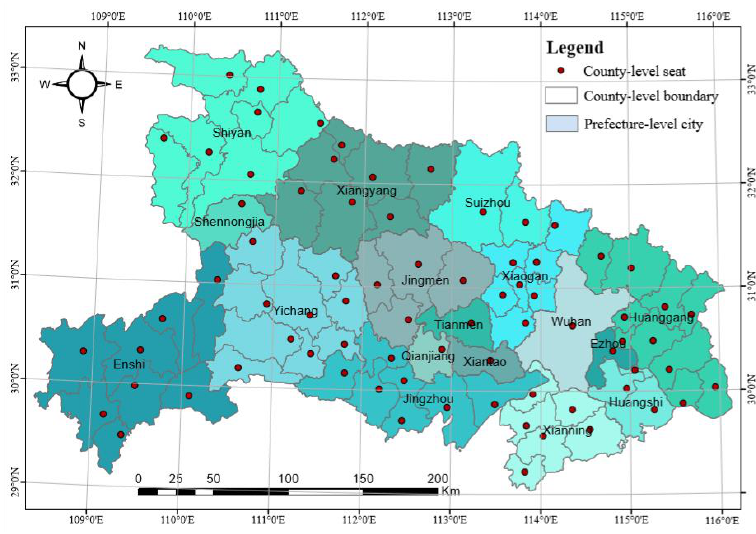
Figure 1. The map of the study area in Hubei province, China.